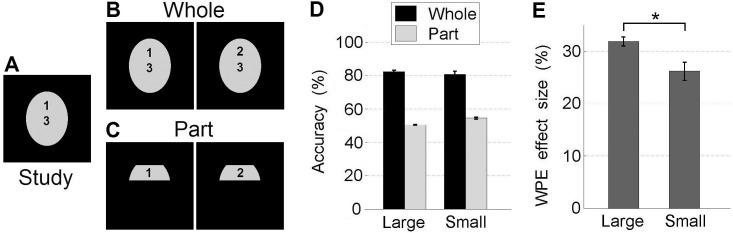
Tuning size accounts for the Whole-Part Effect (WPE).(A) Schematic for Study face. (B) Schematic for Whole condition: two choices (differing only in the eye region) are presented, to be matched to the study face from memory. (C) Schematic for Part condition: two choices (eye regions cropped from Whole condition) to be matched to the study face. (D) Mean accuracies for choosing correctly the Study face. (E) WPE effect size (Whole accuracy–Part accuracy) varies with tuning size. Error bars: SEM.